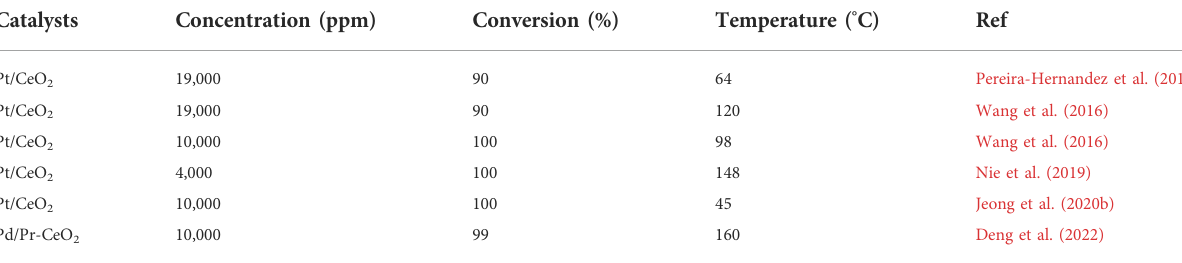
TABLE 1 The catalytic performance comparison of SACs on CO